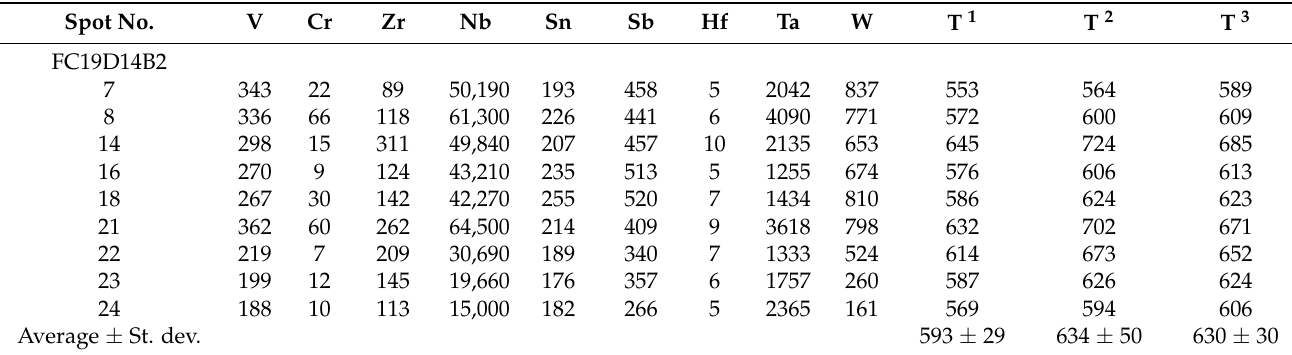
Table 4. LA–ICP–MS trace element analyses (ppm) of rutile deposits in the study area and their estimated temperature ( ◦ C) of crystallisation. Spot